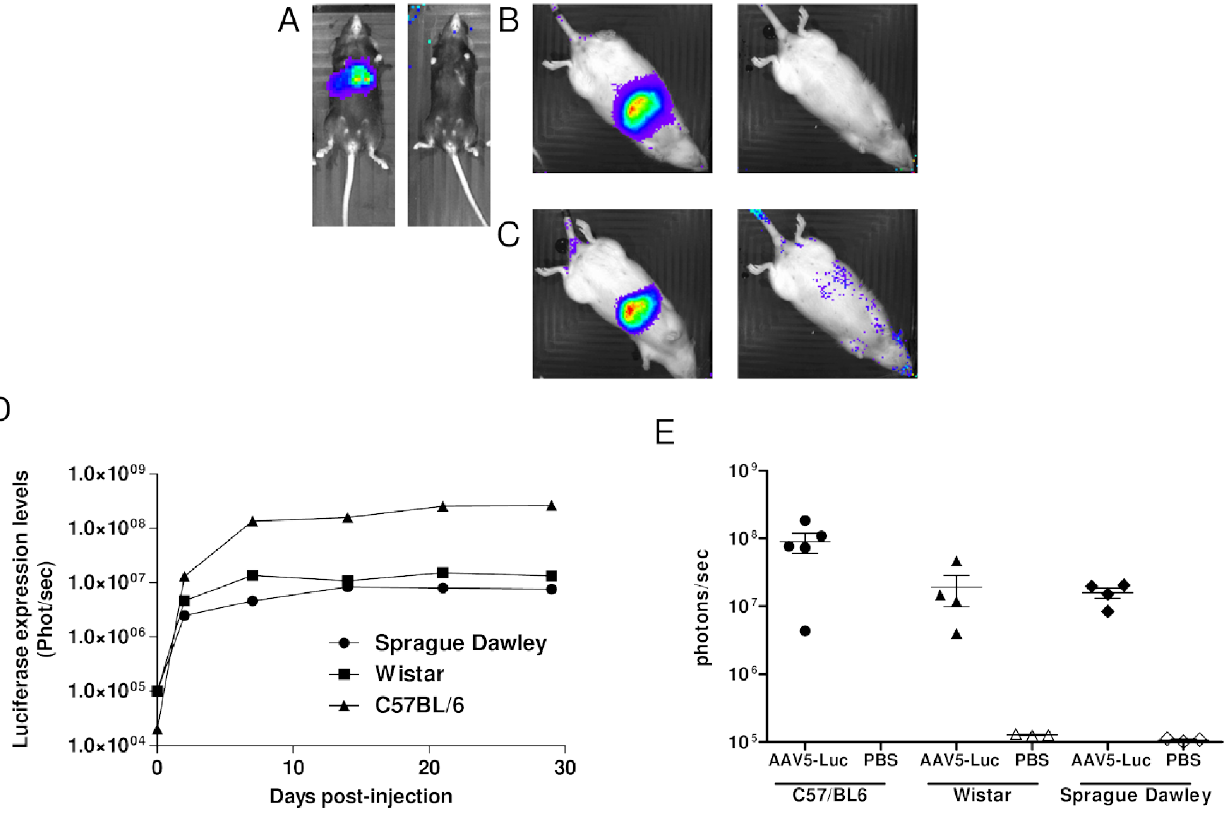
Figure 3. Invivo optical images of the CCD signal intensity in the liver of C57/BL6 female mice and Sprague Dawley/Wistar female rats injected with rAAV2/5-Ealb-hAAT-Luciferase-polyAPBGD-VD183 or PBS + / + + 5% sucrose controlled buffer matrix. (A) C57/BL6 mice, (B) Sprague Dawley rats and (C) Wistar rats all at day 30 after injection, (D) Luciferase expression levels measured in time (E) Luciferase expression at day 30 post-viral injection.